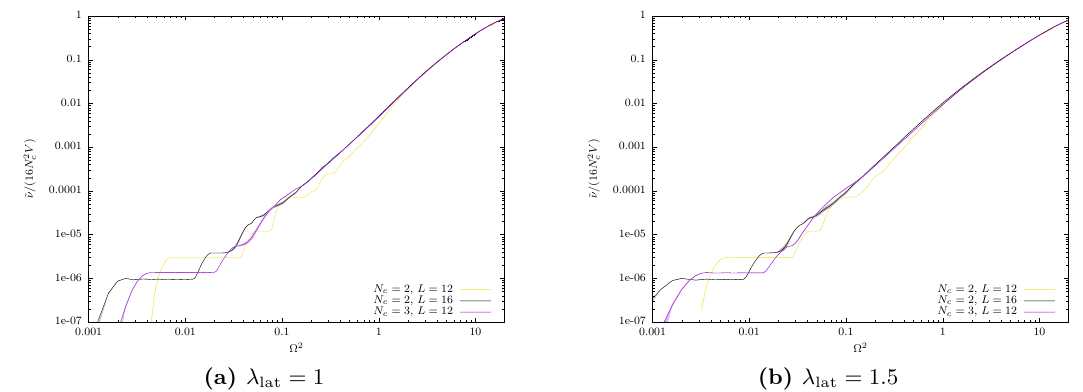
Figure 11. Normalized mode number for different volumes L 4 and gauge groups U( N c ) at couplings λ lat = 1 (left) and λ lat = 1 . 5 (right).